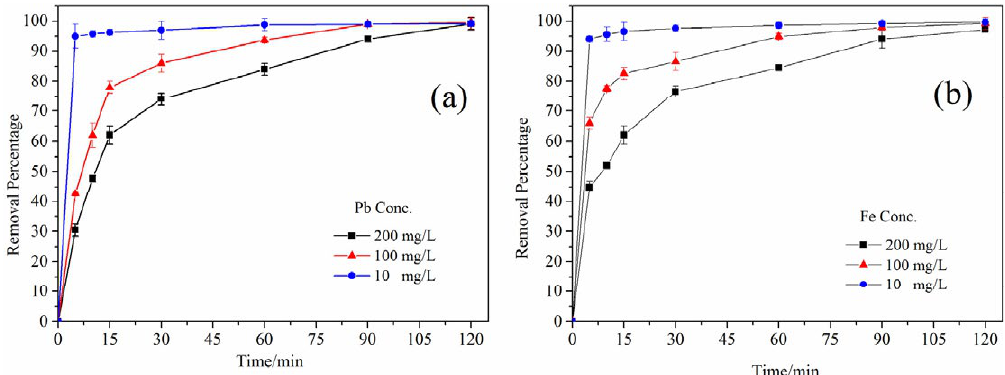
Fig. 2. Kinetic adsorption of a) Pb 2+ and b) Fe 2+ on calcium carbonate nanoparticles, (pH= 5.5, T=25 ºC, adsorbent dosage =1 g/L).